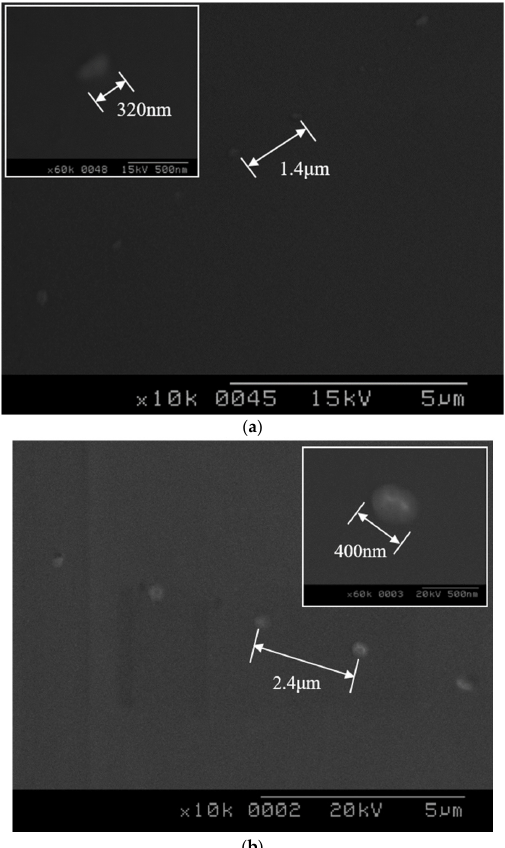
Figure 5. SEM images of melted dots on different-thickness transfer films. Transfer film thicknesses were ( a ) 39 μ m and ( b ) 51 μ m, while the dots’ diameters were 320 nm and 400 nm, respectively. Inset represents the SEM image taken at 60,000x magnification to show the diameter of melted dot. The effectiveness of the film in ( b ) was on a par with that of commercially available films.